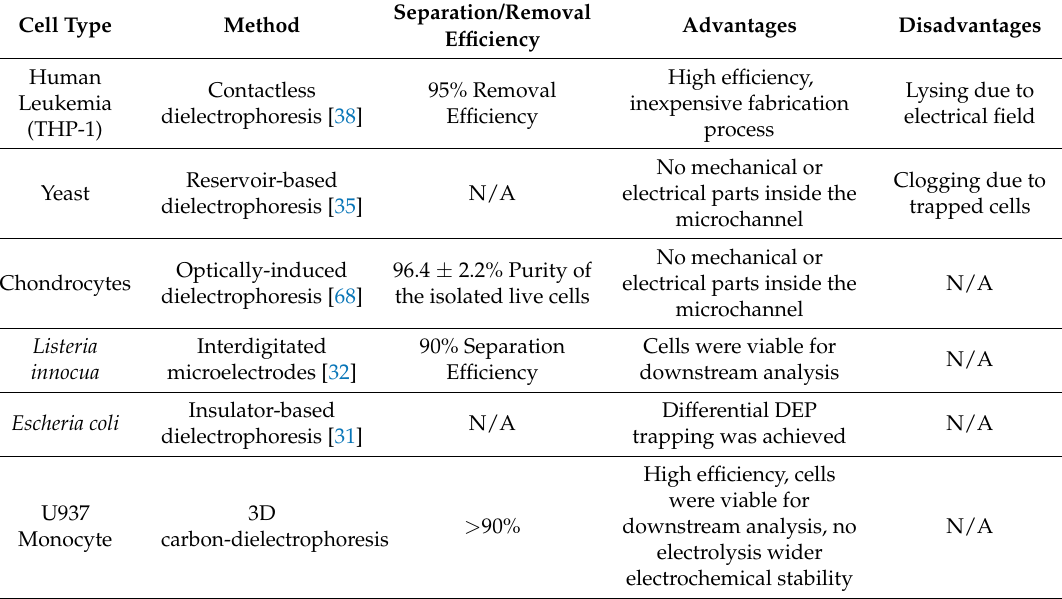
Table 1. Different dielectrophoresis methods for separation of living cells from dead